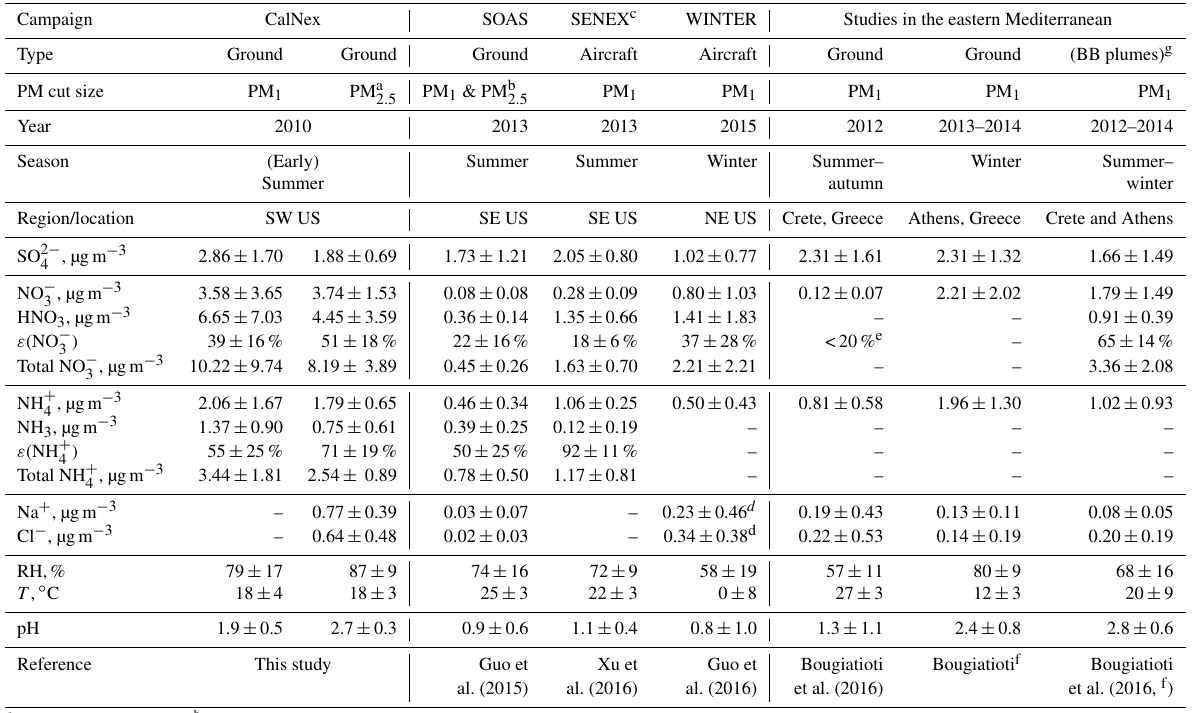
Table 2. Comparisons between different studies for particle pH, major inorganic ions and gases and meteorological conditions. All pH values are from ISORROPIA-II run in forward mode. The campaign acronyms other than CalNex stand for Southern Oxidant and Aerosol Study (SOAS), Southeastern Nexus of Air Quality and Climate (SENEX), and Wintertime Investigation of Transport, Emissions, and Reactivity